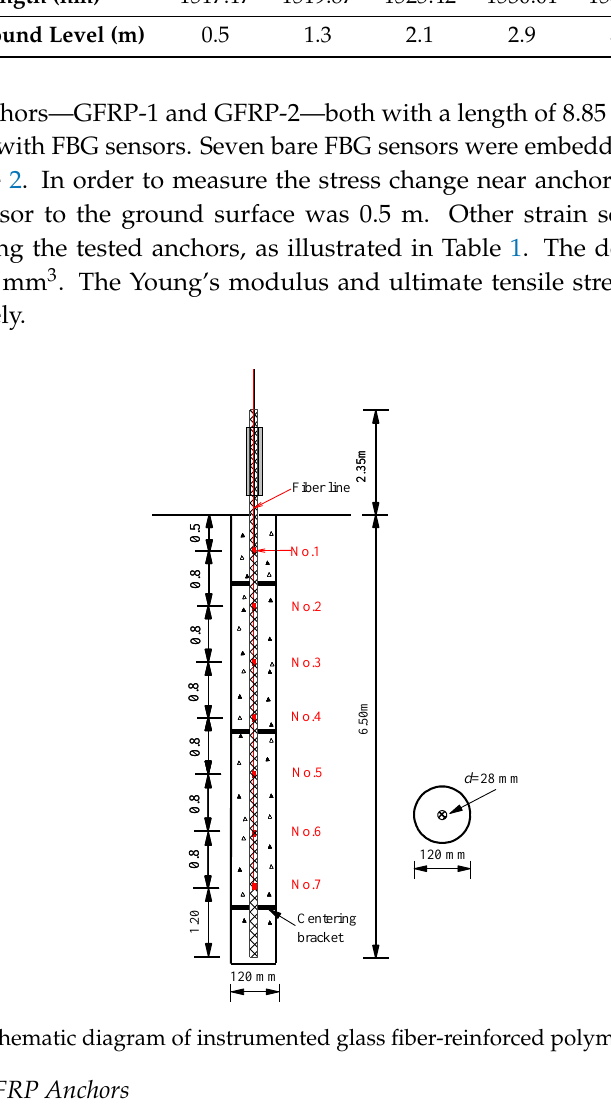
Figure 1. Fiber line with bare FBG sensors.